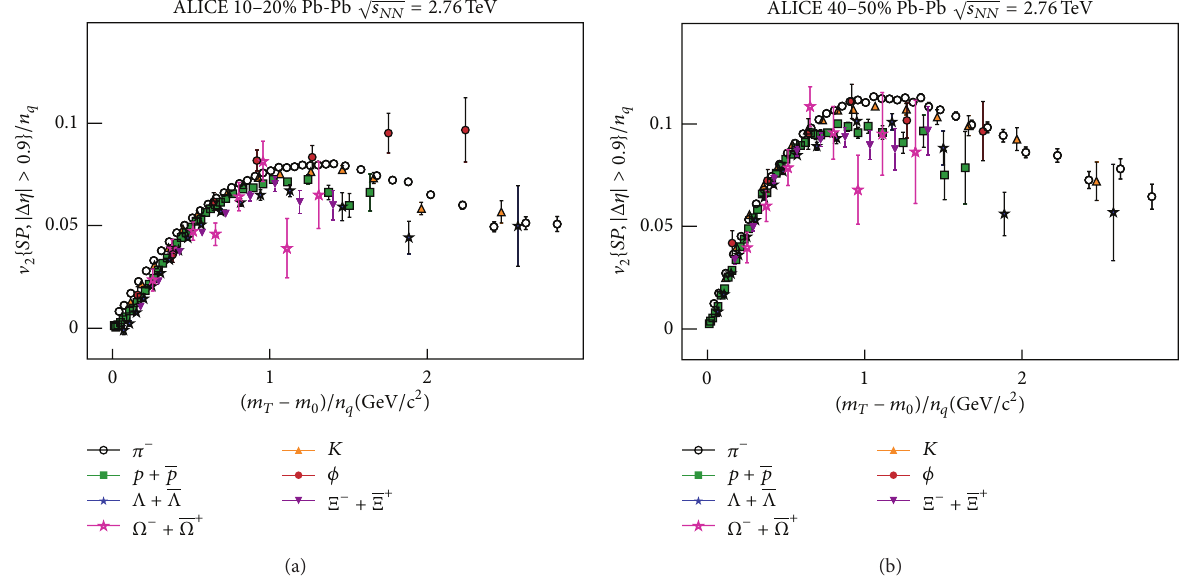
Figure 12: The NCQ-scaled elliptic flow, V 2 /𝑛 𝑞 , versus (𝑚 𝑇 −𝑚 0 )/𝑛 𝑞 for 10–20% and 40–50% central Pb + Pb collisions for selected identified particles [31]. Only statistical error bars are shown. The figure has been taken from the presentation at Quark Matter 2014 by ALICE